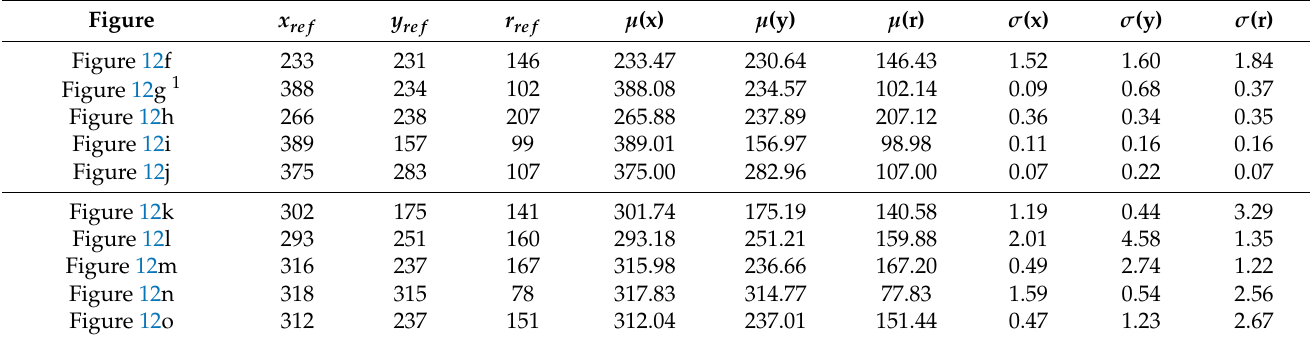
Table 5. Reference parameters detected by the reference system (columns 2–4), average of detected parameters (columns 5–7), and standard deviation of each one (columns 8–10).